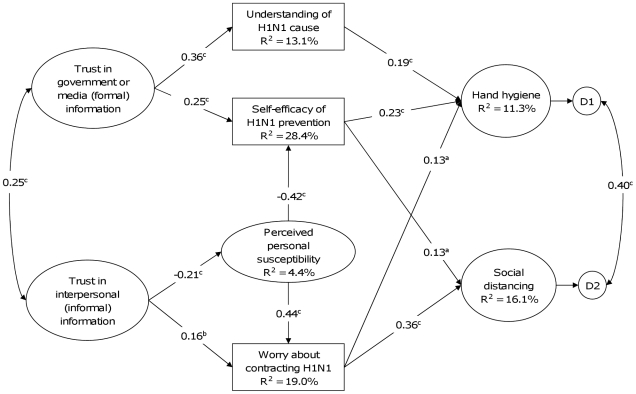
Structural equation model for health protection against the 2009 influenza pandemic among Hong Kong general people.N (the sample size) = 1001. The numbers represent standardized path coefficients (β). Only paths with statistically significant (p<0.05) β≥0.1 are included. Significant paths with β<0.1 were considered trivial and excluded to aid clarity. a p<0.05, b p<0.01, c p<0.001.